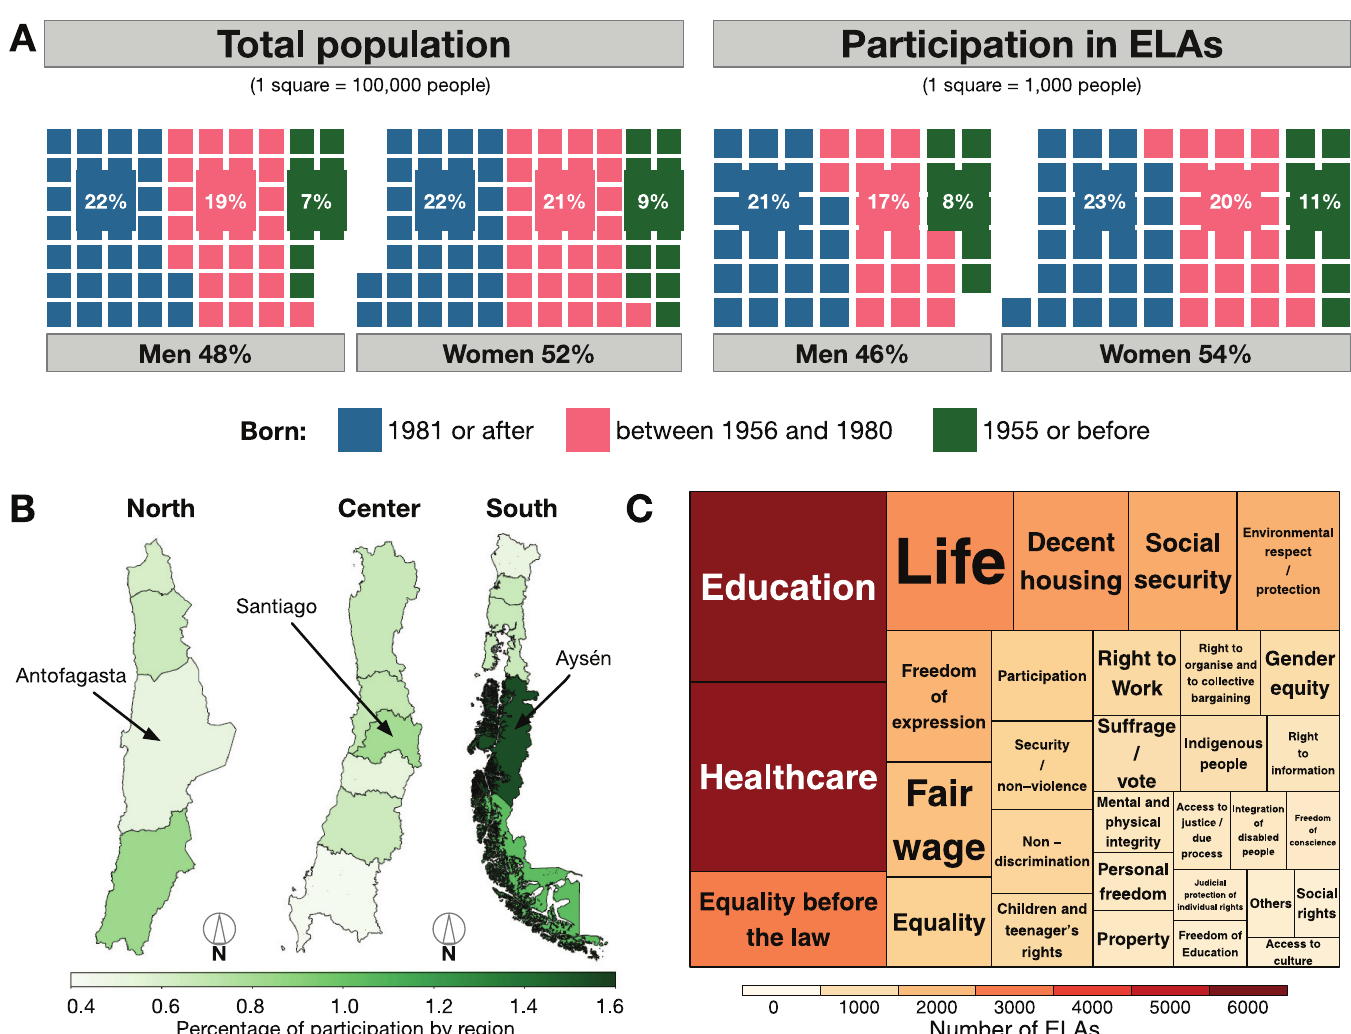
Fig 1. Citizen participation in ELAs. A) Composition of national population from Census 2017 data and of citizen participation in self-convoked encounters (ELAs), by gender and generational cohorts (colors). Participation distribution differs significantly from the population distribution. However, the difference is negligible according to the Cohen’s d standard. Participation distribution differ significantly from the population distribution. However, according to the Cohen’s d standard the difference is small. The contingency tables and chi-squared test results can be found in the appendix (S1 and S2 Tables in S1 File). B) Percentage of the population participating in ELAs per region in Chile. From left to right, the northern macro-zone, the center macro-zone, and the southern macro-zone. The map files are publicly available on the Library of the National Congress of Chile website. C) What constitutional rights do people select at the country level? The tree-map depicts the most